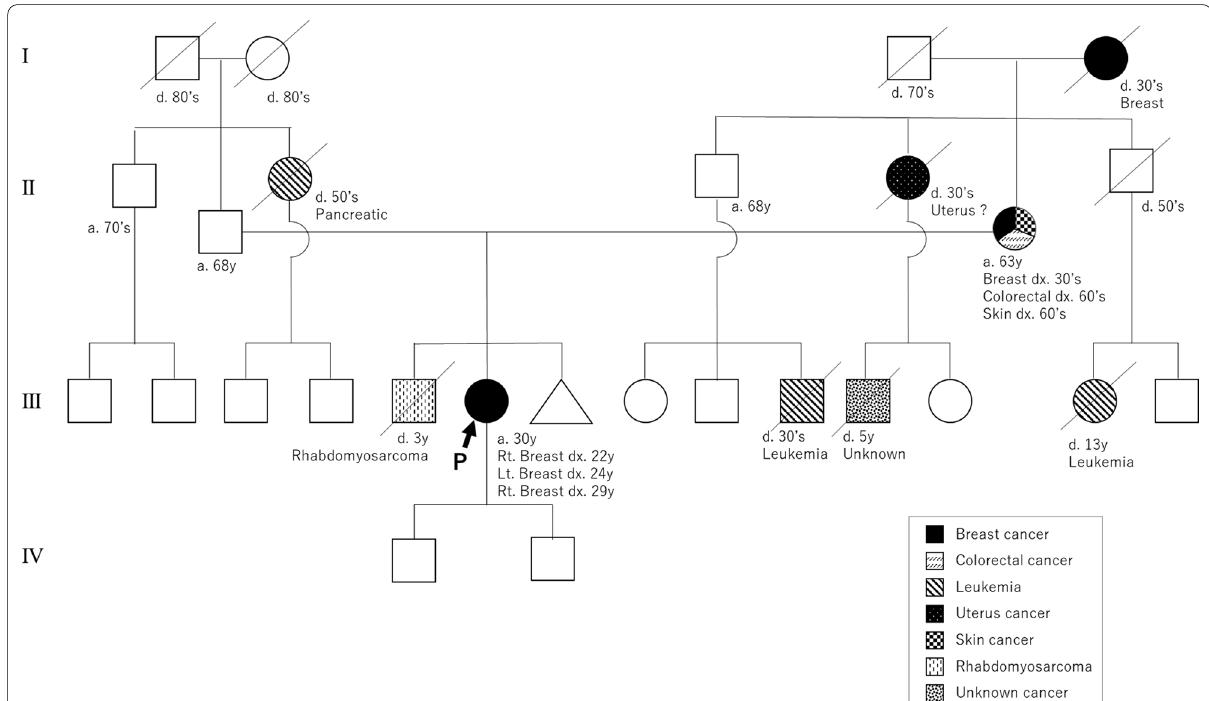
Fig. 1 Pedigree of cancer history. The patient is presented as the first proband (P) in the third generation. The patient’s mother was affected by breast, colorectal, and skin cancer, and was positive for the germline TP53 mutation. The patient’s brother died of rhabdomyosarcoma at the age